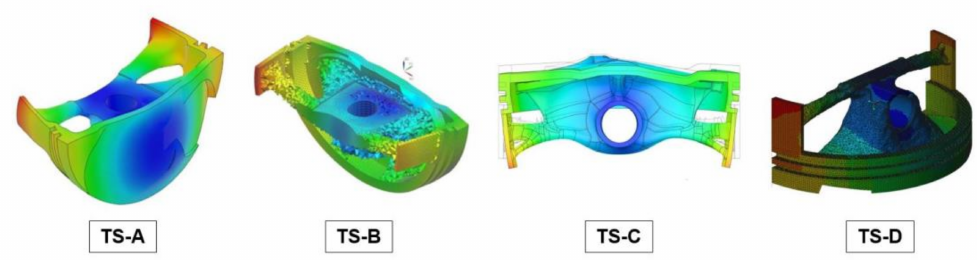
Figure 6. Preliminary Finite Element Analysis of results respectively from TS-A, TS-B, TS-C and